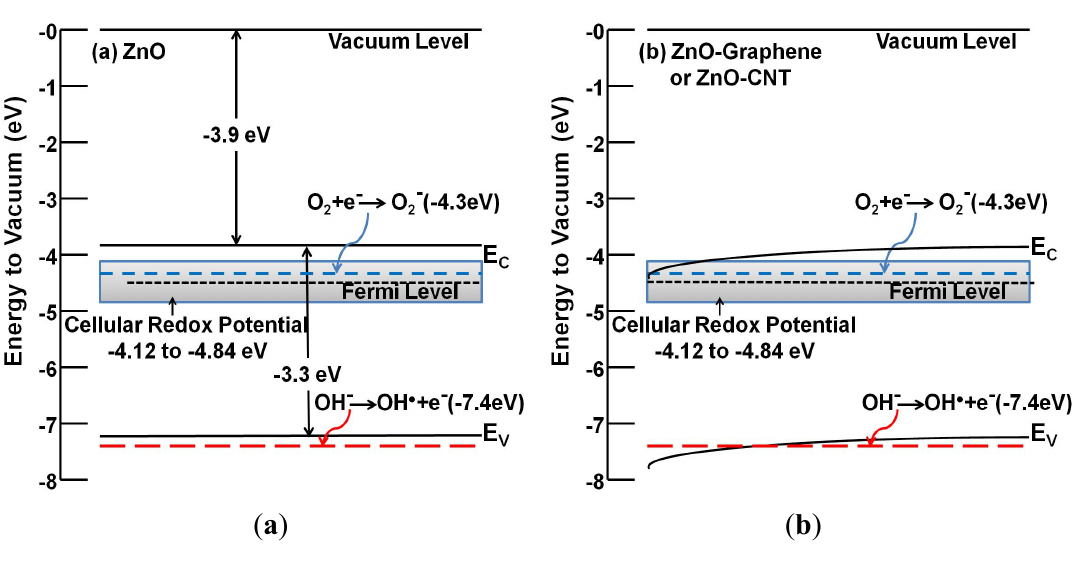
Figure 1. Bandgap energetics diagram of ( a ) ZnO and ( b ) ZnO-graphene or ZnO-CNT NH. The diagrams also show the relative energetic positions of the cellular redox potential ( − 4.12 to − 4.84 eV) and relevant oxygen species (superoxides and hydroxy